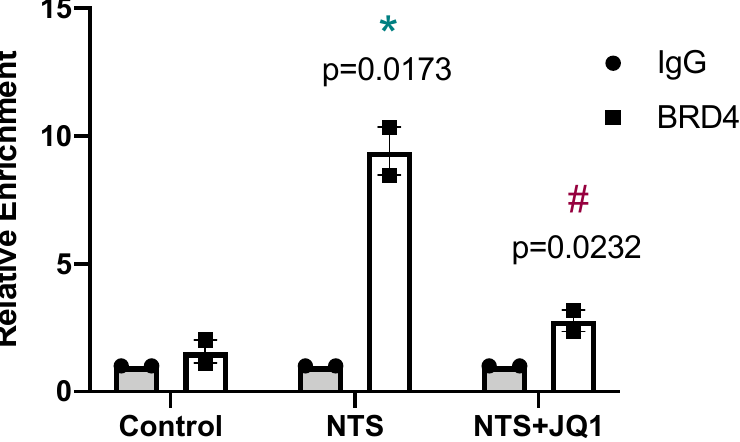
Figure 3. Grem-1 is a direct target of iBETs. ChIP assays were performed in renal samples using an antibody specific for BRD4 or normal rabbit IgG, the latter being a negative control. Enrichment of BRD4-binding regions in the promoter of mouse Grem-1 was quantified by qPCR using specific primers. In each group, samples were pulled (4–7 mice per group). Data are from two independent experiments and each qPCR was run in triplicate. Results are expressed as the n -fold enrichment of anti-BRD4 antibody relative to the negative control antibody (considered to be 1). * p < 0.05 vs. control; # p < 0.05 vs. NTS-injected mice.